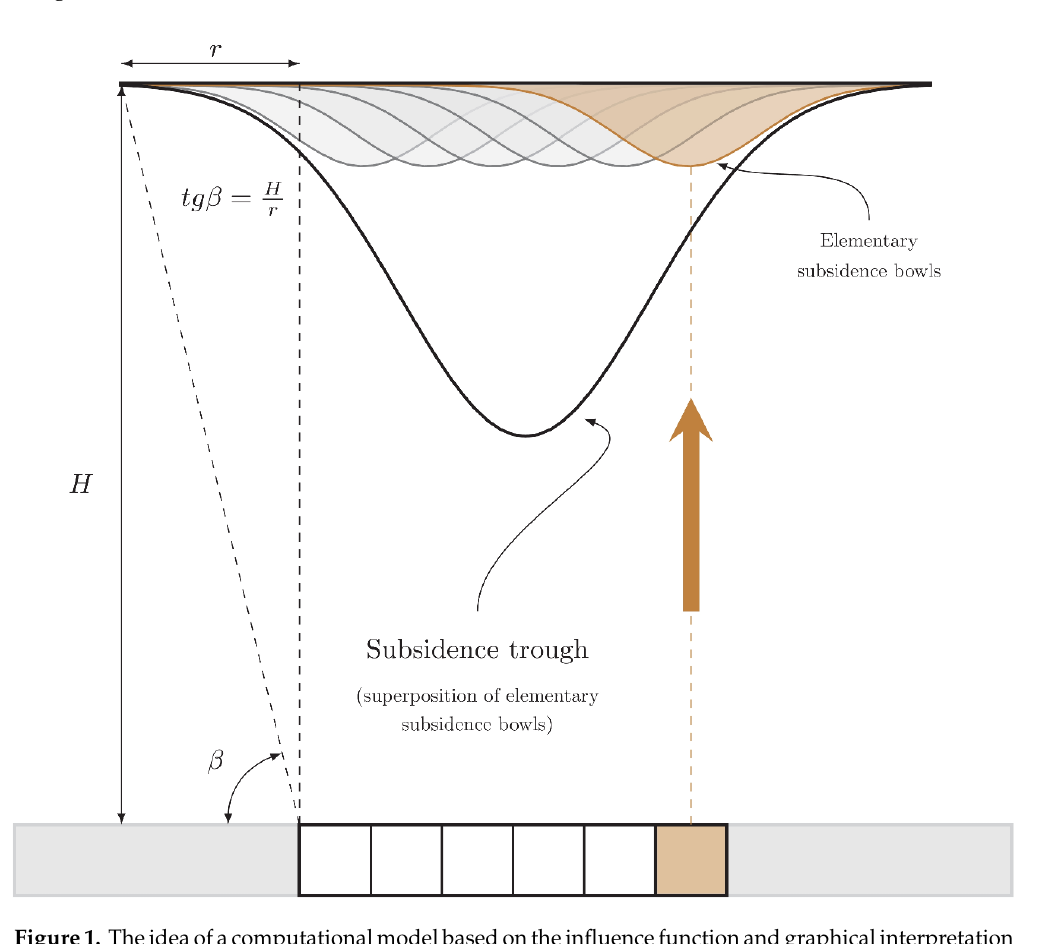
Figure 1. The idea of a computational model based on the influence function and graphical interpretation of the tgβ parameter. The dark orange arrow visualizations the influence function, which represents the deformation process in rock mass.